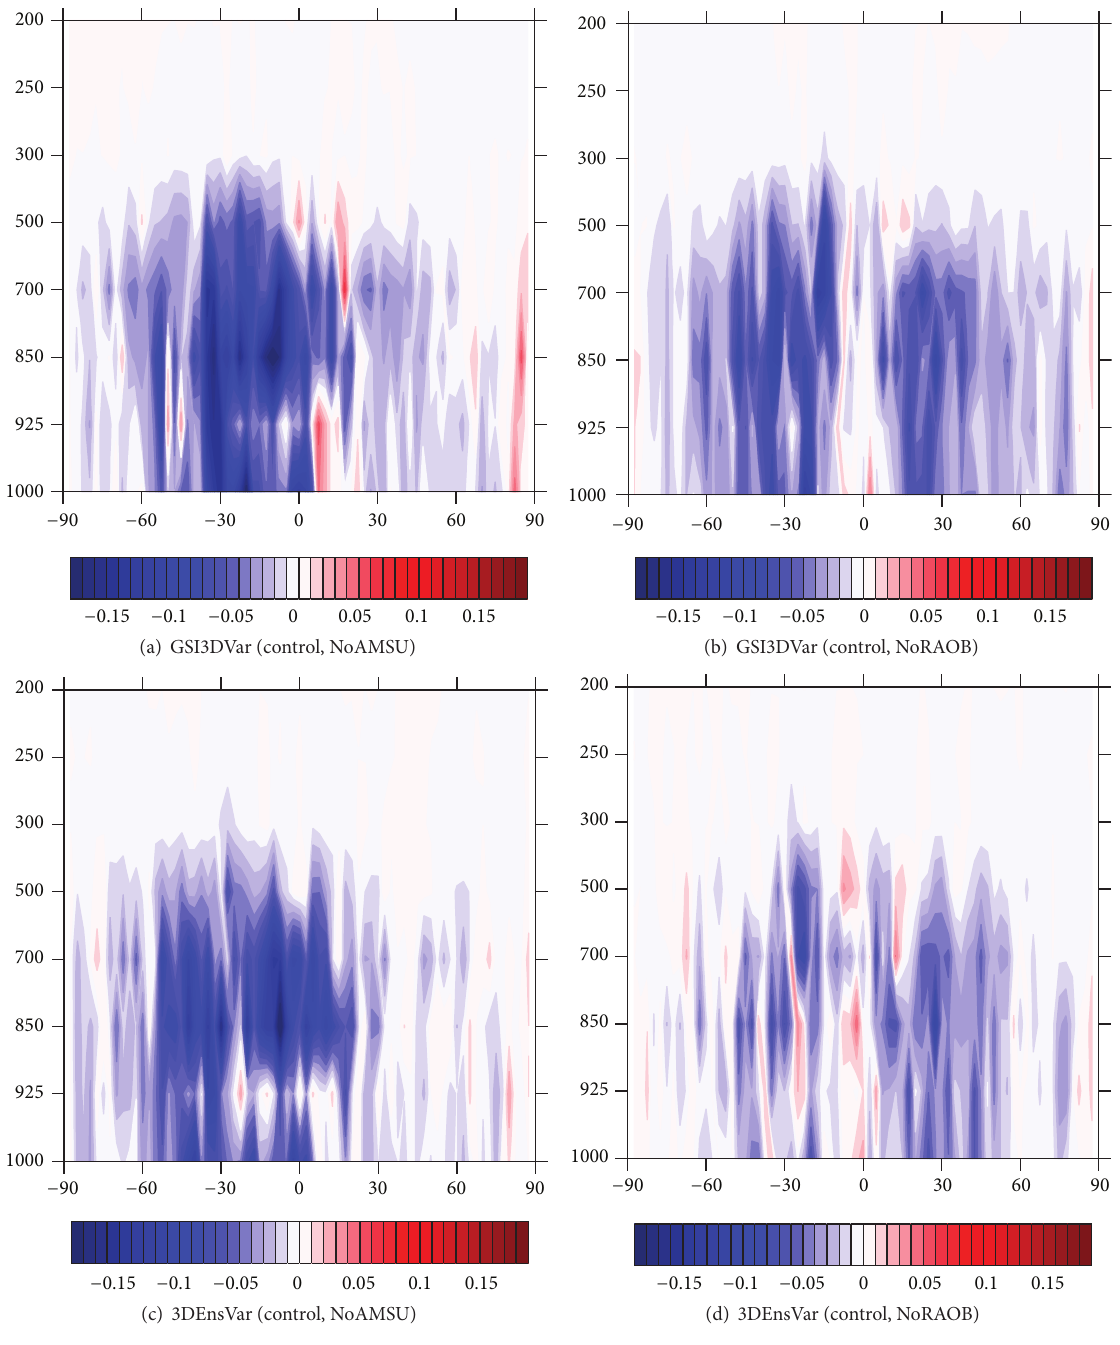
Figure 8: Zonally averaged root-mean-square error difference for 72 hr specific humidity (gkg −1 ) forecast between (a) GSI3DVar and GSI3DVar-NoAMSU, (b) GSI3DVar and GSI3DVar-NoRAOB, (c) 3DEnsVar and 3DEnsVar-NoAMSU, and (d) 3DEnsVar and 3DEnsVar- NoRAOB. Color definitions are the same as in Figure